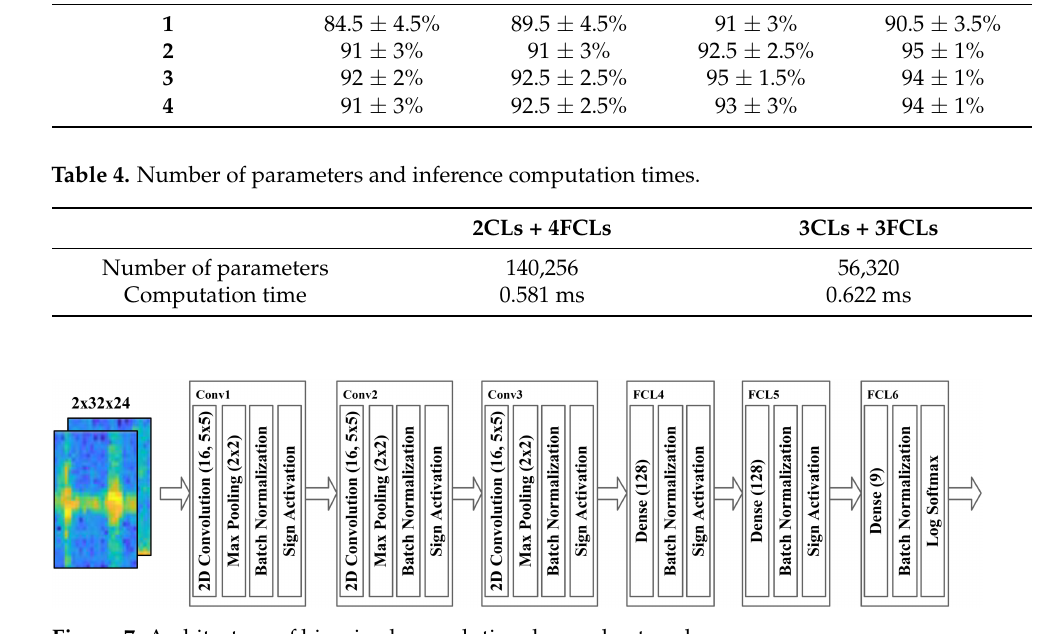
Figure 7. Architecture of binarized convolutional neural network.